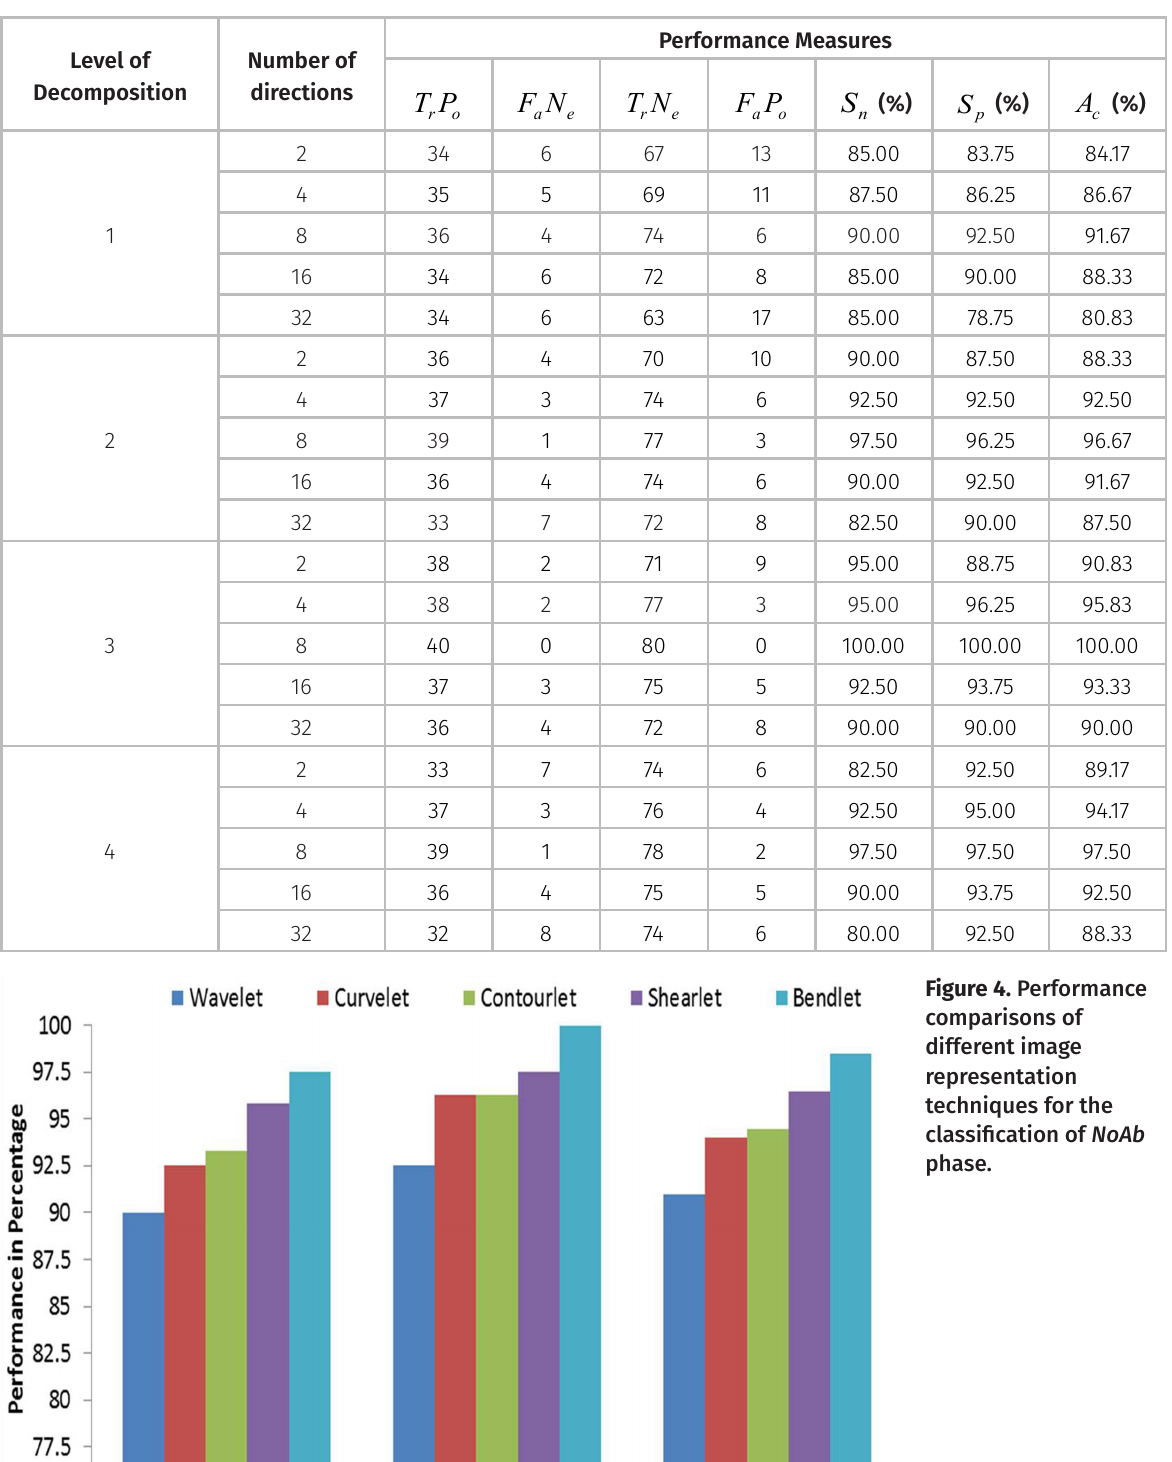
Table III. SVM-RBF Classifier performance for BeMa phase. Level of Number of Decomposition directions